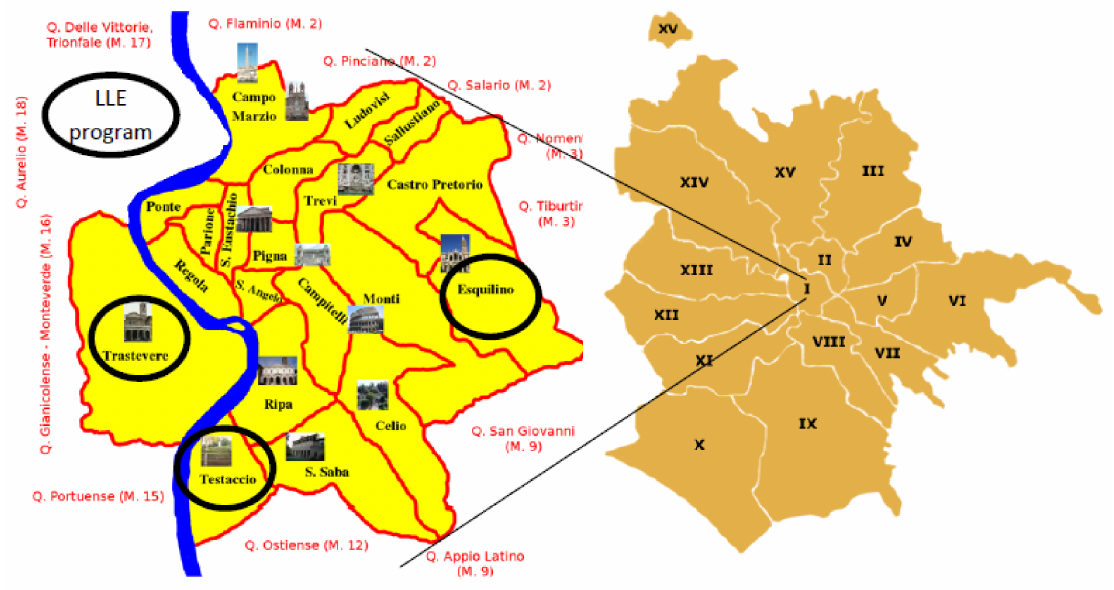
Figure 1. Rome, 1st administrative district (2015). LLE, Long Live the Elderly